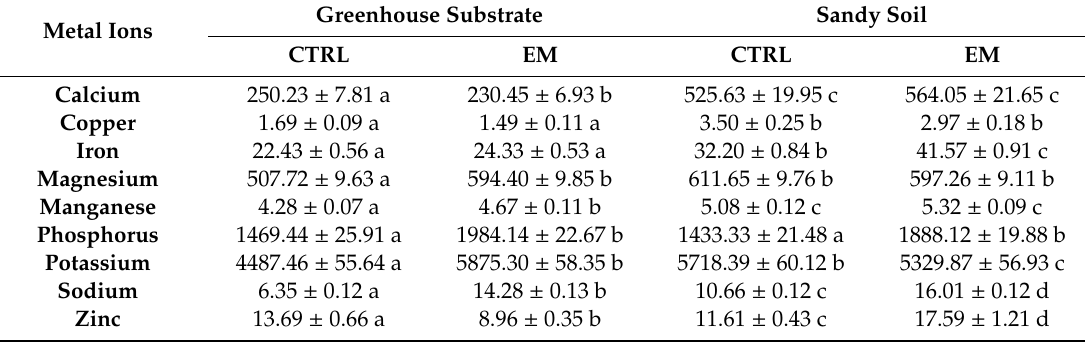
Table 2. Metal ion contents of seeds from bean plants grown in di ff erent soils, not treated or treated with EM. Data are expressed as mg of metal per kg of bean seed. In each row, values (mean ± SEM) designated with the same letters are not significantly di ff erent between treatments of the same substrate ( p ≤